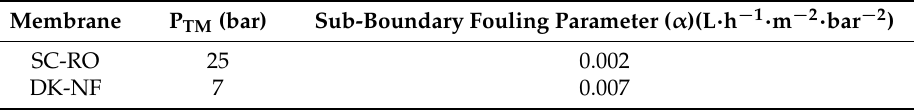
Table 7. Sub-boundary fouling parameter ( α , L · h − 1 · m − 2 · bar − 2 ).